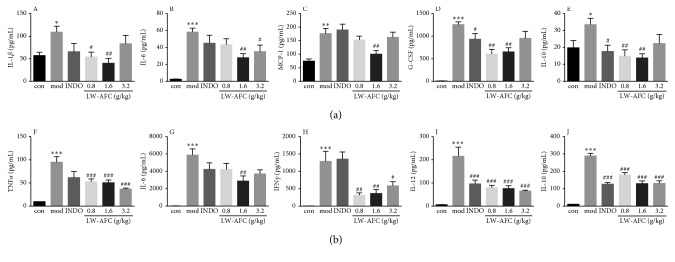
Effect of LW-AFC on cytokine secretion in the (a) hippocampus and (b) plasma of LPS-treated mice. ∗∗∗p < 0.001, ∗∗p < 0.01, and ∗p < 0.05vs. con and Student's t-test; ###p < 0.001, ##p < 0.01, and #p < 0.05vs. mod, one-way ANOVA, and Dunnett's test, mean ± SD, n = 5–8. A, IL-1β; B, IL-6; C, MCP-1; D, G-CSF; E, IL-10; F, TNF-α; G, IL-6; H, IFNγ; I, IL-12; J, IL-10. con, control; mod, model; INDO, indomethacin.